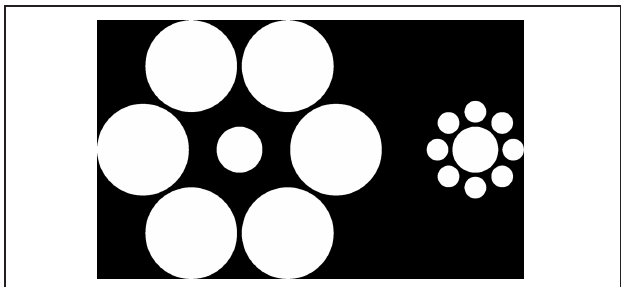
FIGURE 1 | Ebbinghaus illusion. The central disk on the left appears smaller than the physically identical one on the right. (Similar effects are obtained with circles instead of